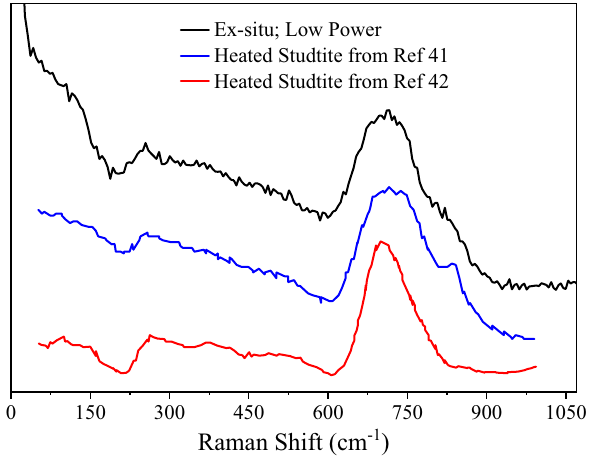
Figure 6. Ex-situ Raman spectra of collected particulates using a low HeNe power (black) plotted along with am-UO x spectra from Thompson et al. 41 (blue) and Spano et al. 42 (red). Comparisons give support for the am-UO x assignment of particulates. Spectra are offset for clarity.